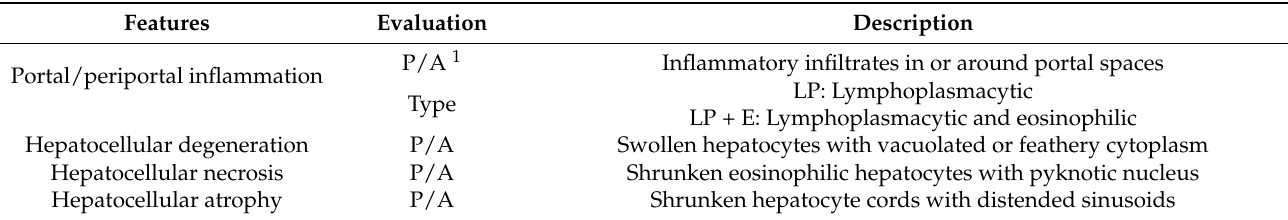
Table A5. Histopathological features evaluated in the liver.